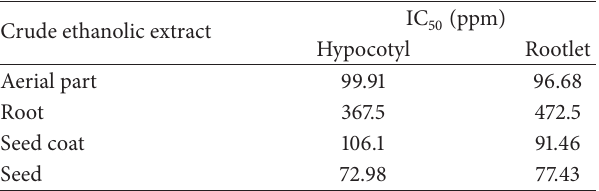
Table 2: IC 50 of crude ethanolic extracts of cultivar BR-1 of A . hypogaea on the inhibition of L . sativa growth of hypocotyls and